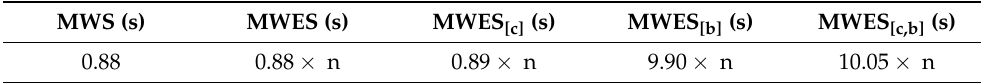
Table 1. Time complexity analysis.